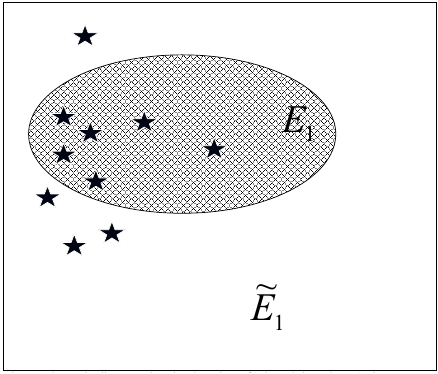
Fig. 1 Schematic diagram showing location of mineral deposits (D) shown as Fig. 2 Schematic diagram showing location of mineral deposits (D) shown as stars are highly associated with igneous batholith . Relatively fewer mineral 1 E E~ . Fig. 1. Schematic diagram showing location of mineral deposits stars are highly associated with alteration zone labeled as . Relatively fewer deposits are located outside of batholith labeled as 2 E 1 mineral deposits are located outside of alternation zone labeled as 2 E~ . Fig. 2. Schematic diagram showing location of mineral deposits ( D ) shown as stars are highly associated with igneous batholith E 1 . ( D ) shown as stars are highly associated with alteration zone la- Relatively fewer mineral deposits are located outside of batholith beled as E 2 . Relatively fewer mineral deposits are located outside labeled as ˜ E 1 . of alternation zone labeled as ˜ E 2 .